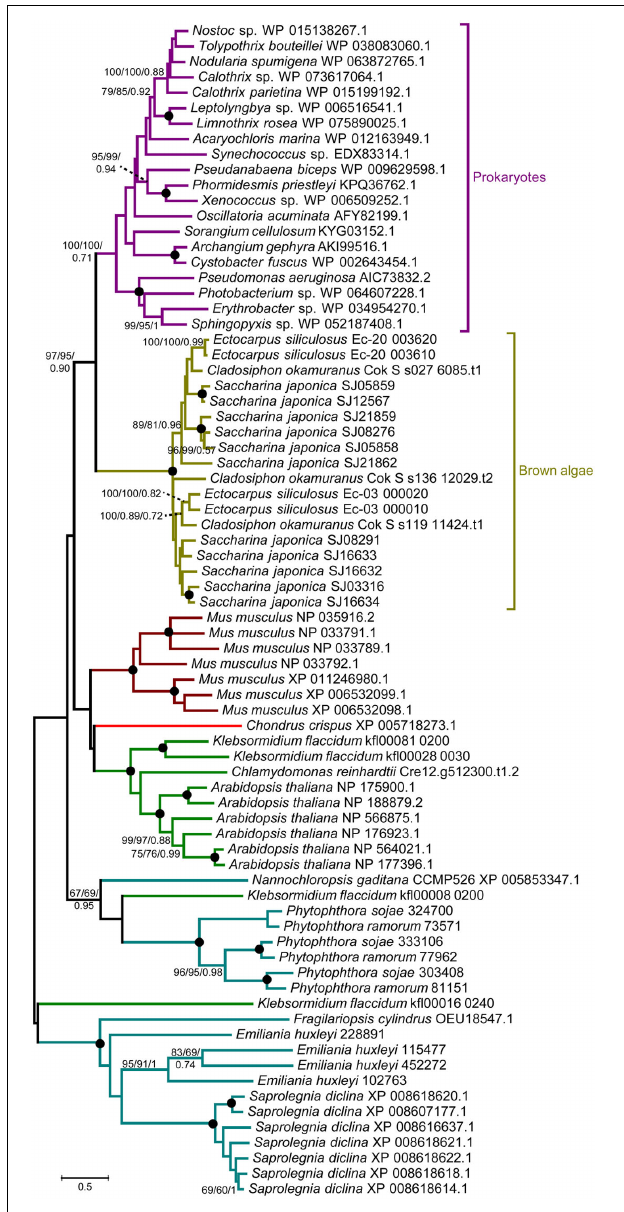
FIGURE 1 | Unrooted ML tree of 76 members of the LOX family from prokaryotes and 14 eukaryote species. Support values correspond to bootstrap values (1000 replicates) for ML and NJ trees and Bayesian posterior probabilities in this order; they are shown only for nodes with ≥ 50% support with all three methods. Nodes with 100% in all methods are shown by a solid dot. The tree was generated using MEGA 7.0 and WAG + G + I model for ML and NJ analyses and BEAST2 for Bayesian